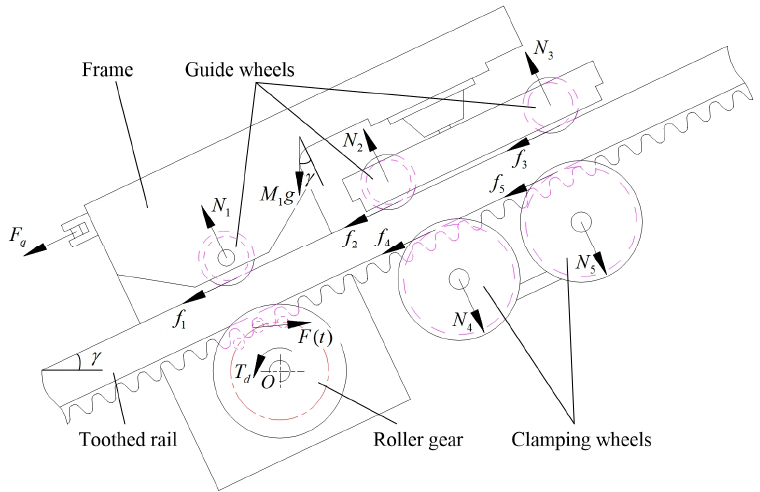
Figure 5. Force analysis of components of the mountain self-propelled electric monorail transporter